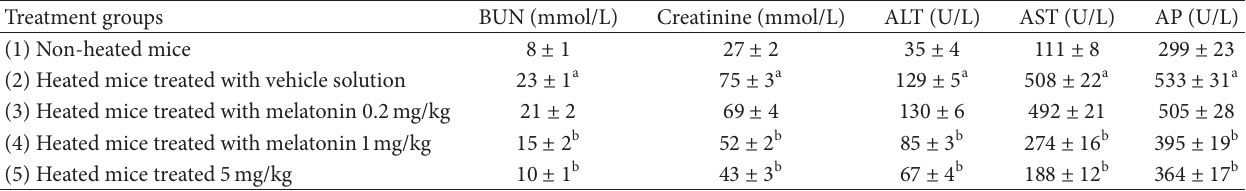
Table 5: Effect of heat exposure on serum levels of blood urea nitrogen (BUN), creatinine, alanine aminotransferase (ALT), aspartate aminotransferase (AST), and alkaline phosphate (AP) in different groups of mice. Treatment groups BUN (mmol/L) Creatinine (mmol/L) ALT (U/L) AST (U/L) AP (U/L) 8 ± 1 27 ± 2 35 ± 4 111 ± 8 299 ± 23 23 ± 1 a 75 ± 3 a 129 ± 5 a 508 ± 22 a 533 ± 31 a 69 ± 4 130 ± 6 492 ± 21 505 ± 28